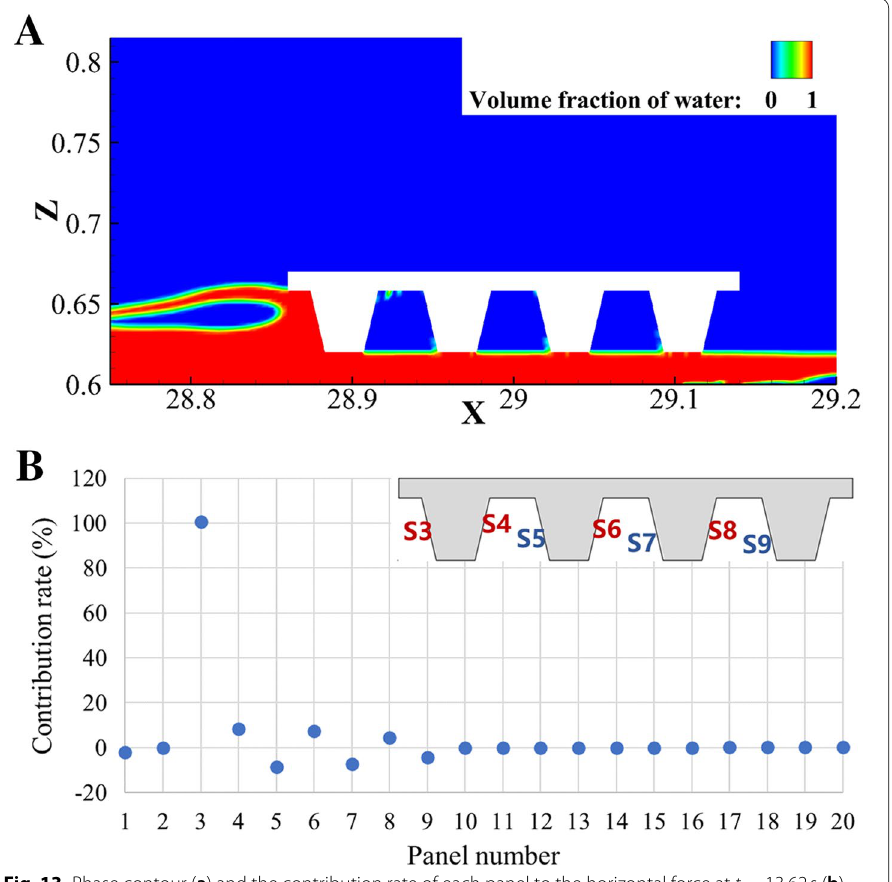
Fig. 13 Phase contour ( a ) and the contribution rate of each panel to the horizontal force at t